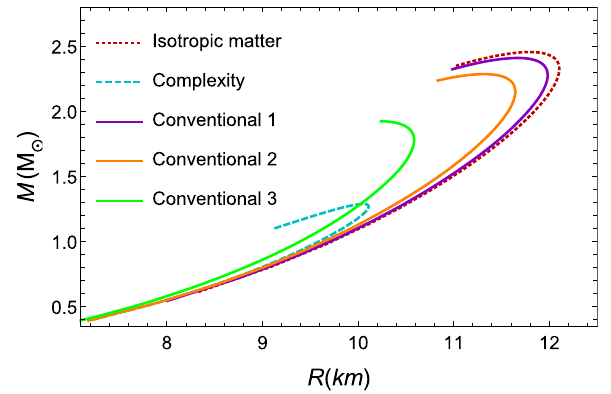
Fig. 7 Mass-to-radius profiles for Model 1 for different cases: (i) con- sidering isotropic matter (dashed), (ii) utilizing the vanishing complex- ity factor formalism (cyan), and (iii) using the conventional method (three curves in between for a = 100 km (less anisotropic), 50 km (middle), 25 km (more